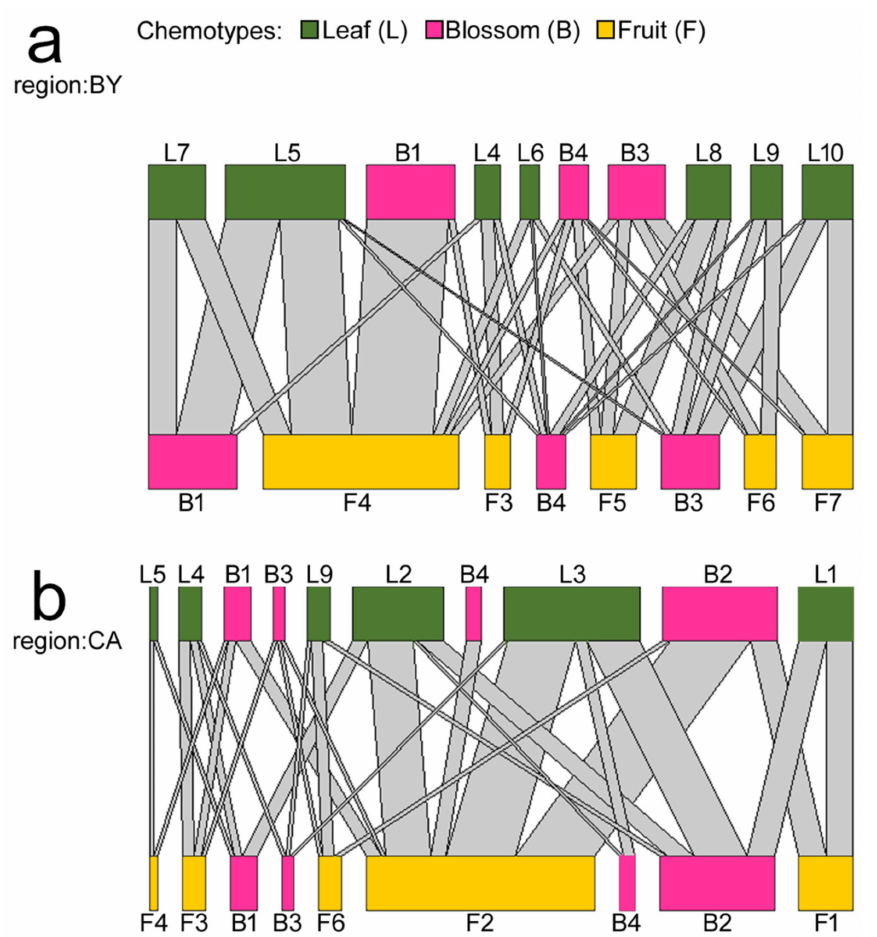
Figure 2. Comparison of the co-occurrence of leaf (L), blossom (B) and fruit (F) chemotypes for E. cicutarium plants originating from Bavaria (( a ); BY, native range) and California (( b ); CA, invaded range). The color of the nodes represents the plant organ (see legend). The width of the connections linking the nodes represents the number of co-occurrences. Several plant part specific chemotypes were only found in one of both regions (see Table 2). Please note that several organ-specific chemo- types are displayed twice in the Figure, as the triangular connection between flowers, leaves and fruits could not be displayed in a hierarchical tripartite